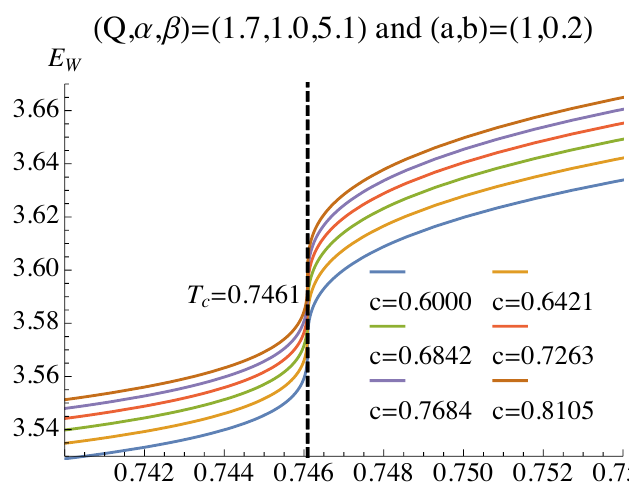
Figure 13 . The temperature vs. EWCS at the second-order phase transition. The phenomenon is qualitatively the same for other configurations and parameters. The red dashed horizontal line represents the critical temperature T c = 0 . 7461 of the second-order phase